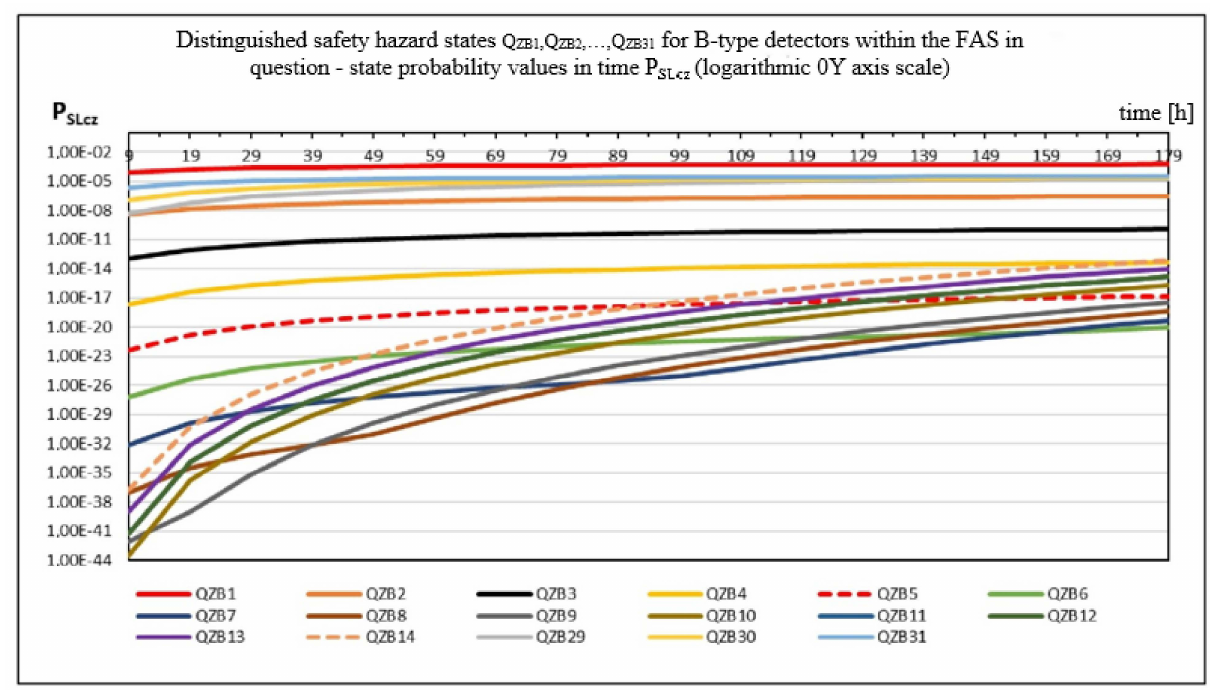
Figure 19. Zonal (partial) availability coefficients for separated technical states of a focused FAS Q B ,Q ZB1 ,Q ZB2 ,Q ZB3 ,